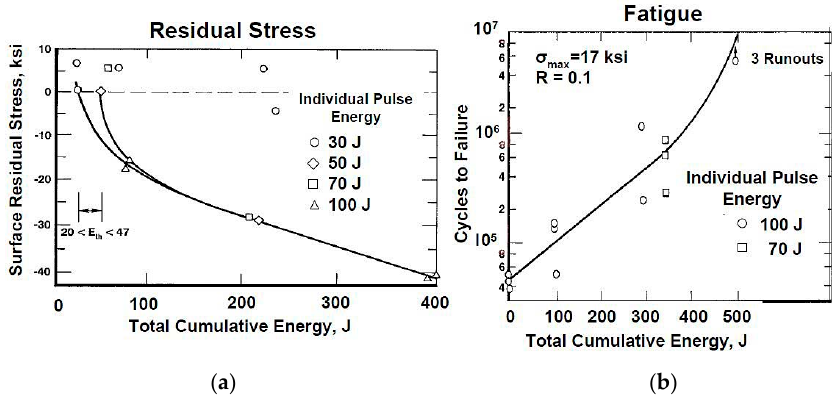
Figure 16. Surface stress and fatigue life of laser shocked, pressed and sintered Fe-2Ni-0.5C powder: ( a ) surface residual stress; ( b ) cyclic fatigue life.